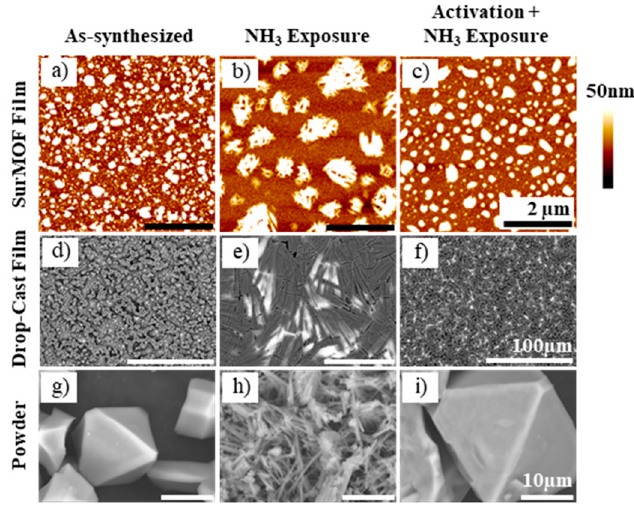
Figure 2. Top: Representative SPM images of HKUST-1 surMOFs ( a ) before exposure to NH 3 ; ( b ) after exposure without activation; and ( c ) after exposure with prior activation. Middle: SEM images of HKUST-1 drop-cast thin film ( d ) before exposure to NH 3 ; ( e ) after exposure without activation; and ( f ) after exposure with prior activation. Note: Due to high conductivity, underlying gold substrate appears bright in SEM images (especially prevalent in ( e ) and ( f )). Bottom: SEM images of HKUST-1 powder ( g ) before exposure to NH 3 ; ( h ) after exposure without activation; and ( i ) after exposure with prior activation. All scale bars in ( a – c ) are 2 μ m, in ( d – f ) are 100 μ m, and in ( g – i ) are 10 μ m.